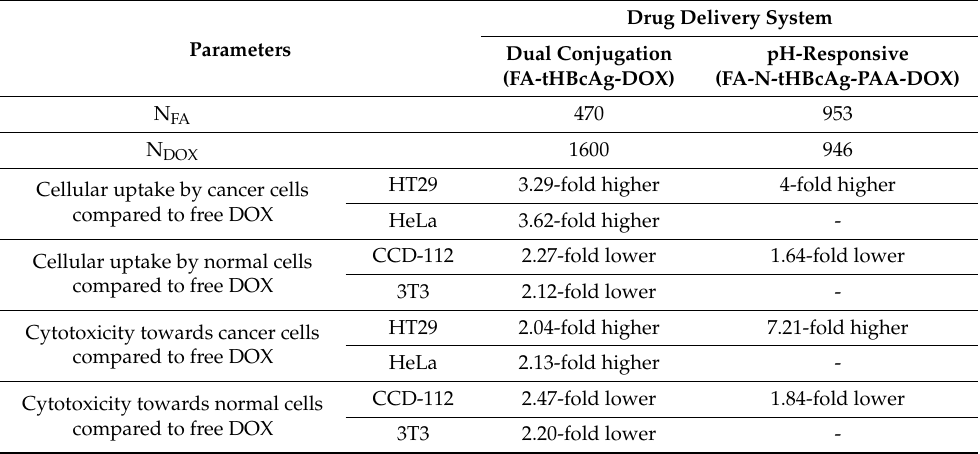
Table 1. Comparisons of different drug delivery systems based on HBcAg